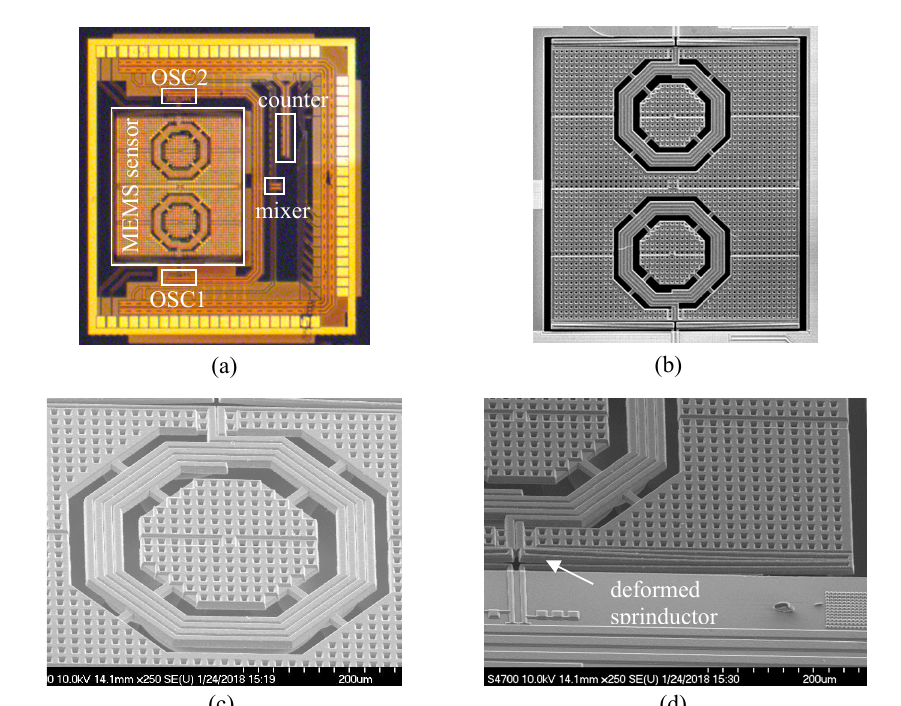
Figure 8. ( a ) Chip micrograph before release, ( b ) scanning electron micrograph of MEMS structure after release, ( c ) high-Q CMOS inductor embedded in proof mass, ( d ) deformed sprinductor.